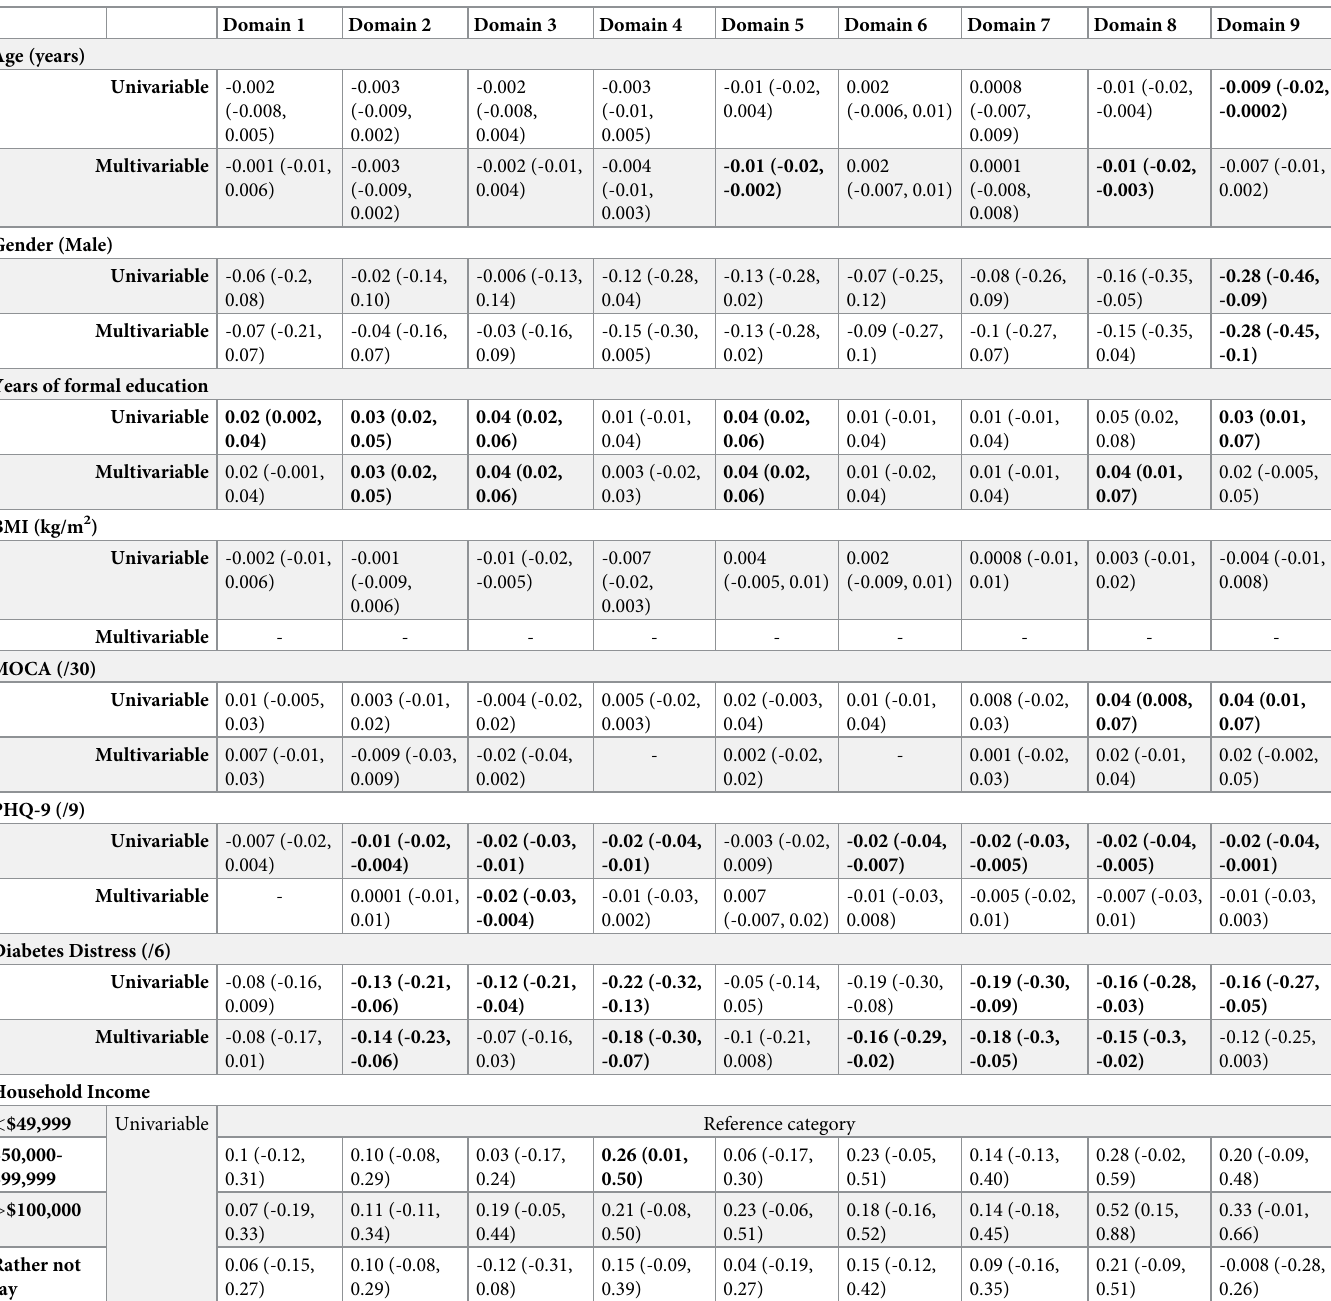
Table 3. Models of the association between mean of each HLQ domain score and demographic characteristics in univariable and multivariable linear